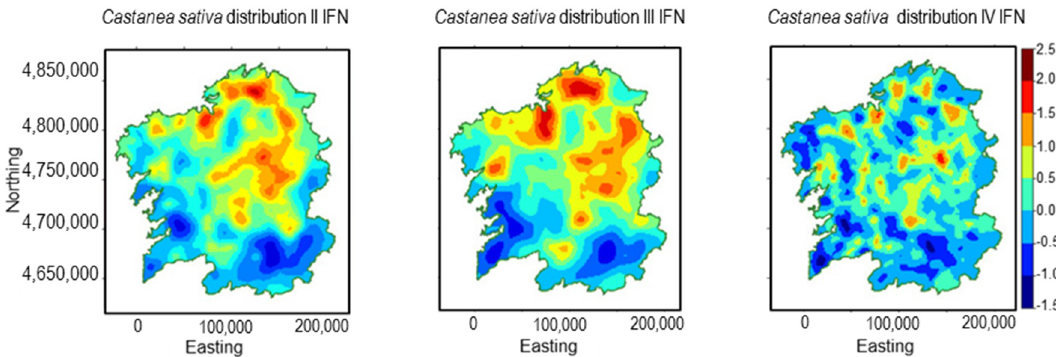
Figure 5. Maps of the posterior means of the spatial field from the spatial model of C. sativa , II, III, and IV forest inventories (coordinates in m.).